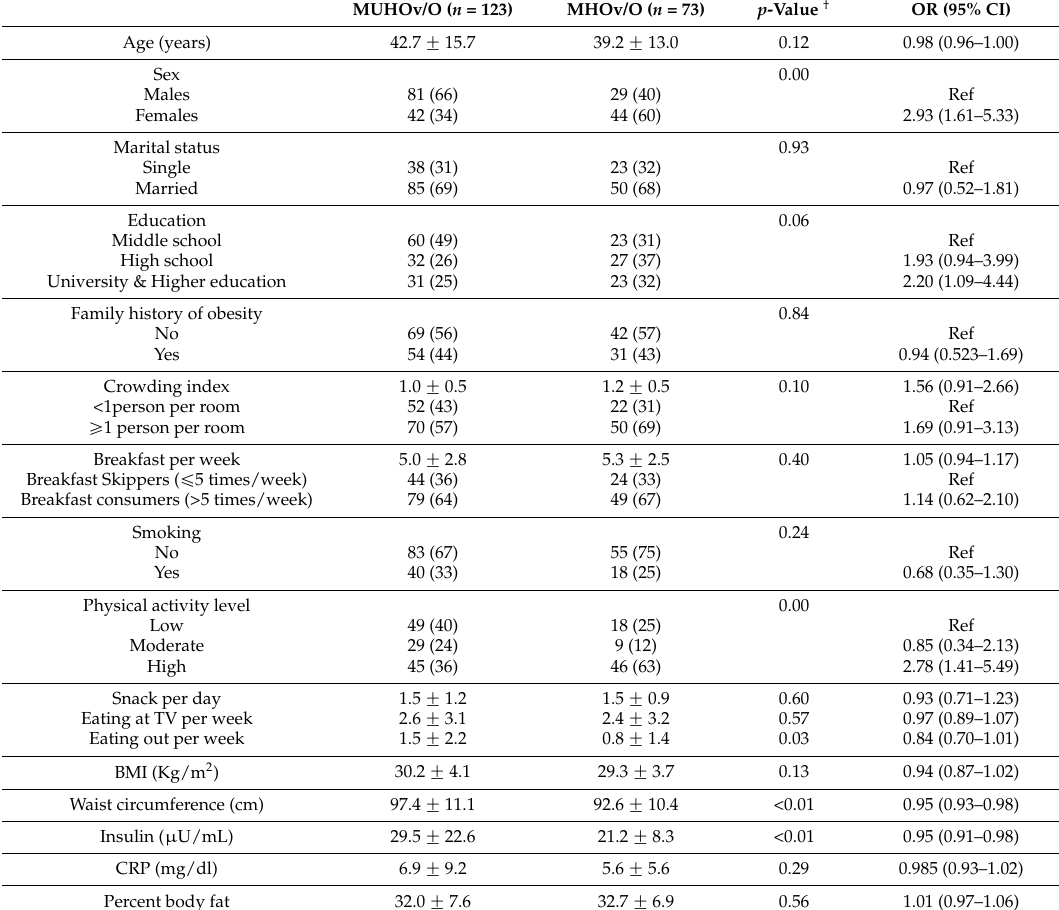
Table 1. Descriptive characteristics of the study population and their association with Metabolically Healthy Overweight and Obesity (MHOv/O), as derived by simple logistic regression ( n =